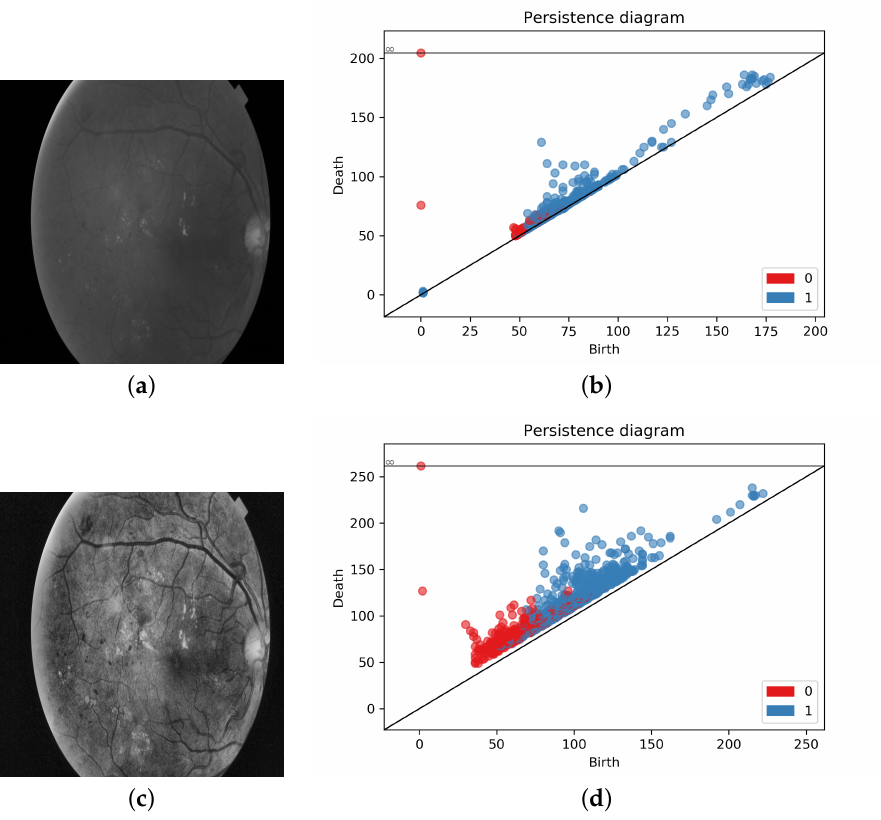
Figure 12. Comparison of the original image and the CLAHE-filtered image. ( a ) Original image, ( b ) persistence diagram of the original image ( a ), ( c ) CLAHE-filtered image, ( d ) persistence diagram of the filtered image ( c